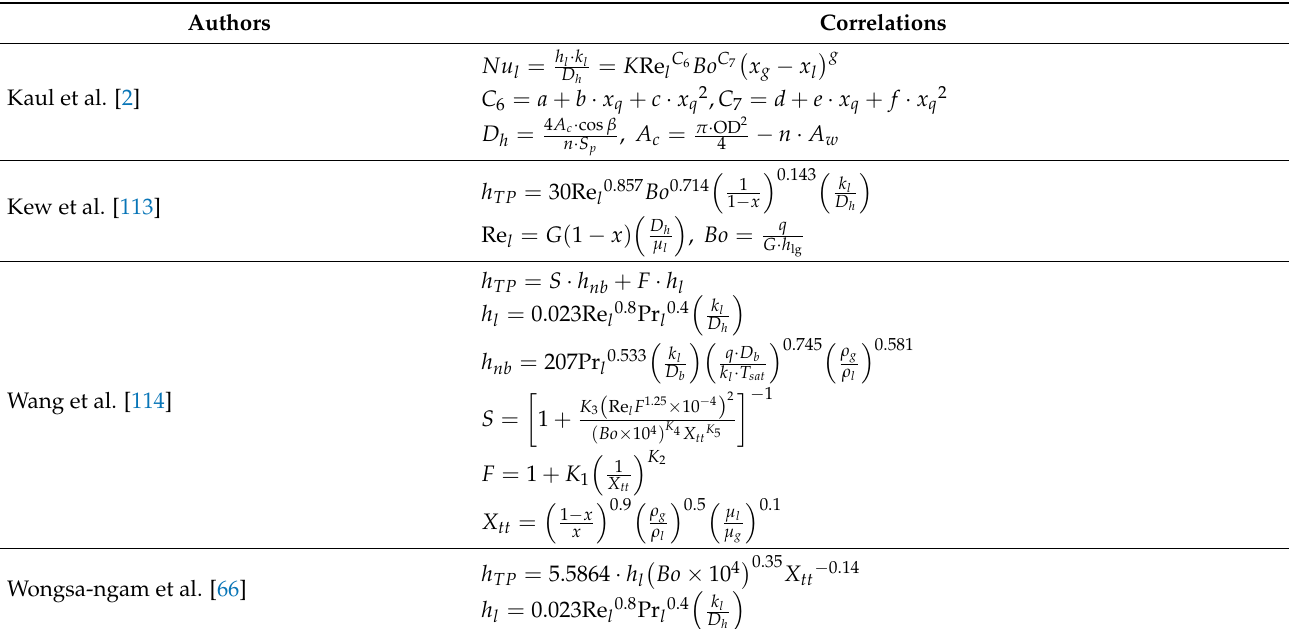
Table 8. Flow boiling models for blended refrigerants to calculate